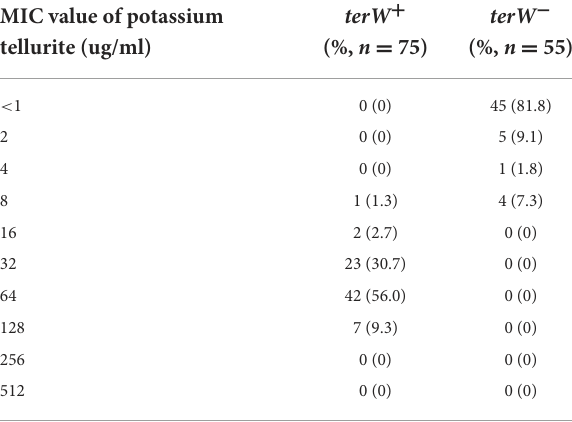
(Table 3). The Kappa value between the MCKT medium culturing method and PCR was 0.936 ( p < 0.05), which indicated that the consistency was